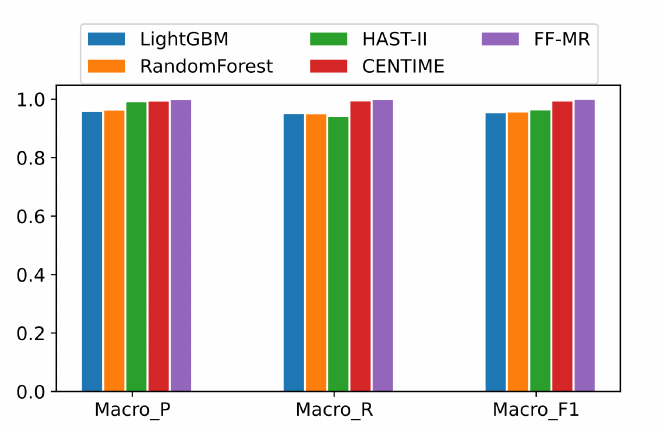
Figure 10. FF-MR vs. other methods on macro-averaging Metrics.